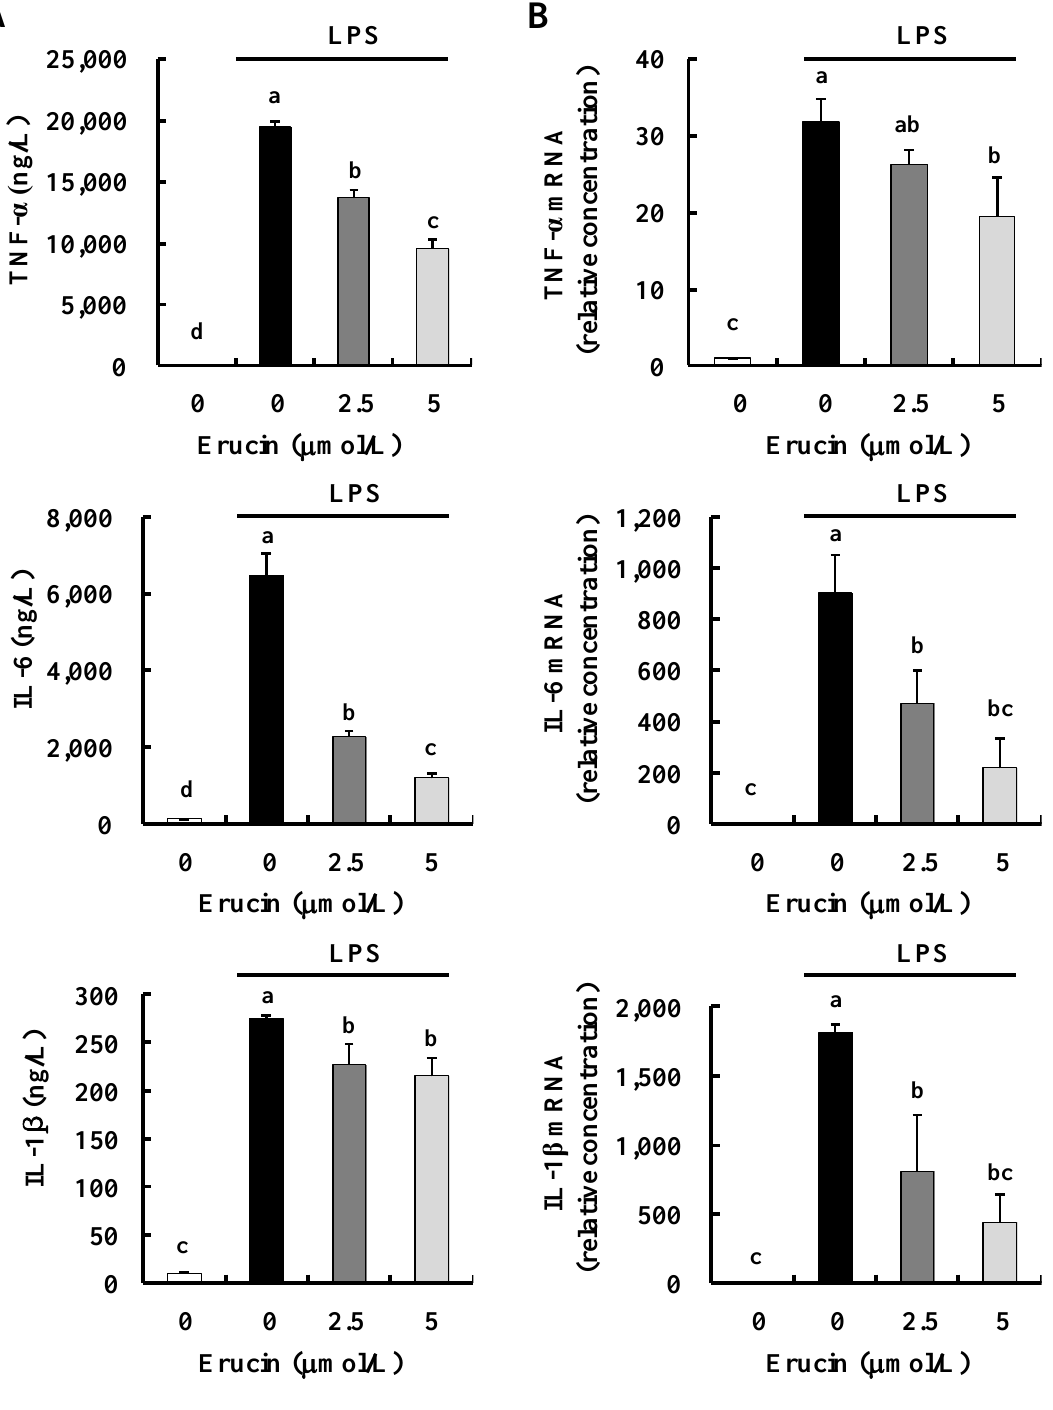
Figure 3. Erucin decreases LPS-induced TNF-α, IL-6 and IL-1β production in RAW 264.7 cells. RAW 264.7 cells were treated with various concentrations of erucin in the presence of LPS. ( A ) The 24-h-conditioned media were collected for the estimation of TNF-α, IL-6 and IL-1β concentrations; ( B ) Total RNA was isolated and real-time RT-PCR performed. Each bar represents the mean ± SEM ( n = 4). Means without a common letter differ ( p <